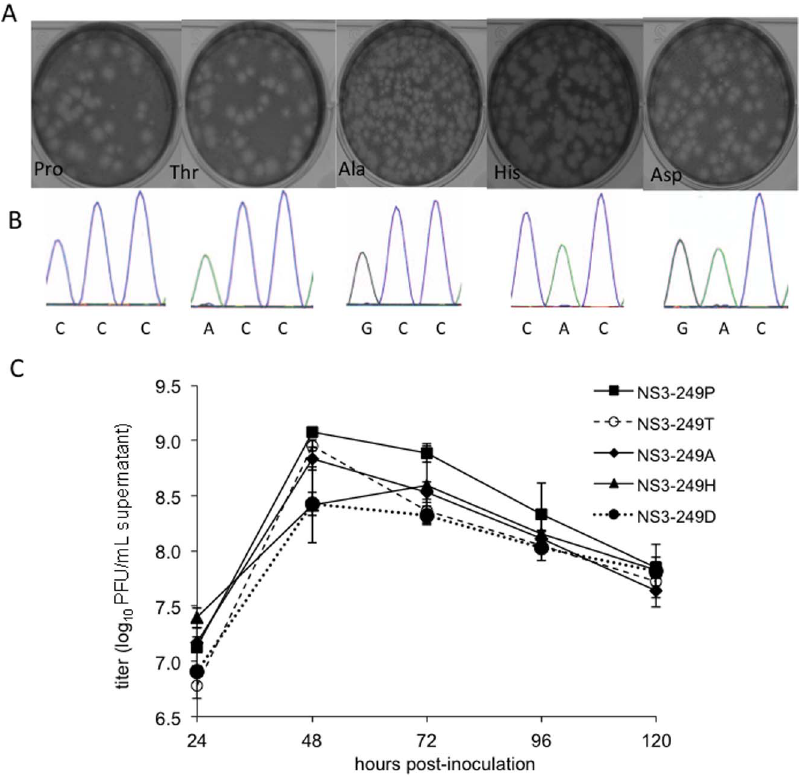
Figure 3. Phenotypic and genetic characterization of rescued WN/IC NS3-249 mutants. (A) WN/IC NS3-249 point mutant plaque phenotypes in a mammalian (Vero) cell line. Plaque diameters were determined to be 1.8 6 0.3 mm (249P), 1.7 6 0.4 mm (249T), 1.4 6 0.3 mm (249A), 1.6 6 0.3 mm (249H), 1.3 6 0.2 mm (249D) and 1.9 6 0.5 mm (249N; not shown). (B) Chromatogram depicting the sequence identity of the NS3-249 loci (genomic position 5456-5458) following generation of the recombinant viruses. (C) WN/IC NS3-249 point mutant growth profiles in a mammalian (Vero) cell line. Cells were inoculated at an MOI of 0.1. Bars represent standard deviation from the mean.